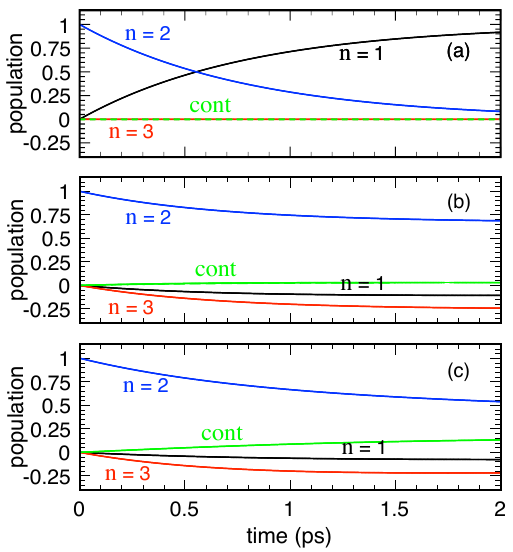
Figure 5. Bound-state populations [see Equation (15)] as well as the continuum (cont) contribution as a function of time for model:s M1 ( a ); M2 ( b ); and M3 ( c ). Reprinted from